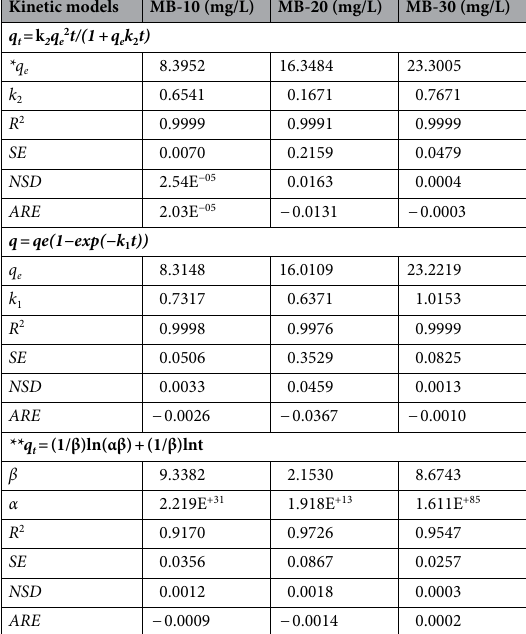
Table 2. Estimated kinetic model parameters for methylene blue adsorption on Cu(OH) 2 -NWs-PVA-AC nano composite at different concentration. *q; adsorbed MB dye (mg/g) at time t (min). **The simple Elovich parameters were estimated without using the origin (q = 0, t = 0).